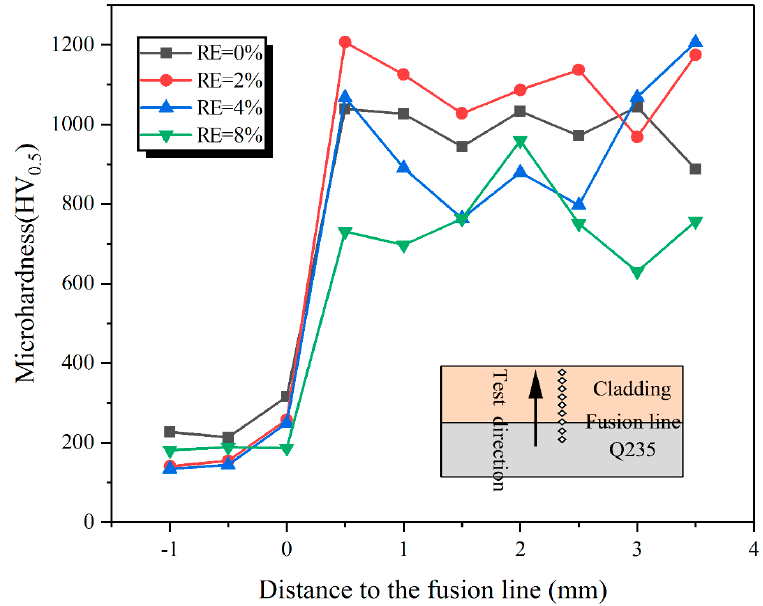
Figure 10. Microhardness of claddings with different RE contents.